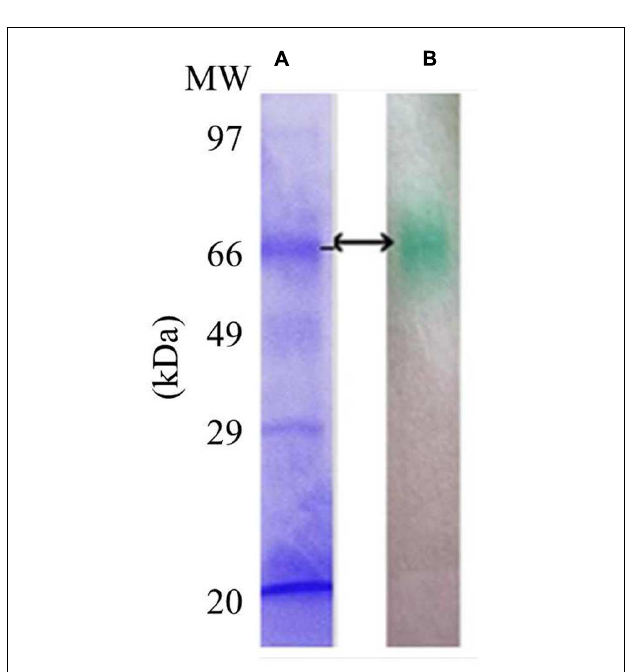
FIGURE 8 | Sodium dodecyl sulfate and Native PAGE of purified LccH. For visualization of protein profiles (A) SDS gels were stained using coomassie brilliant blue R250 and (B) Zymogram of crude LccH with 5 mM ABTS as